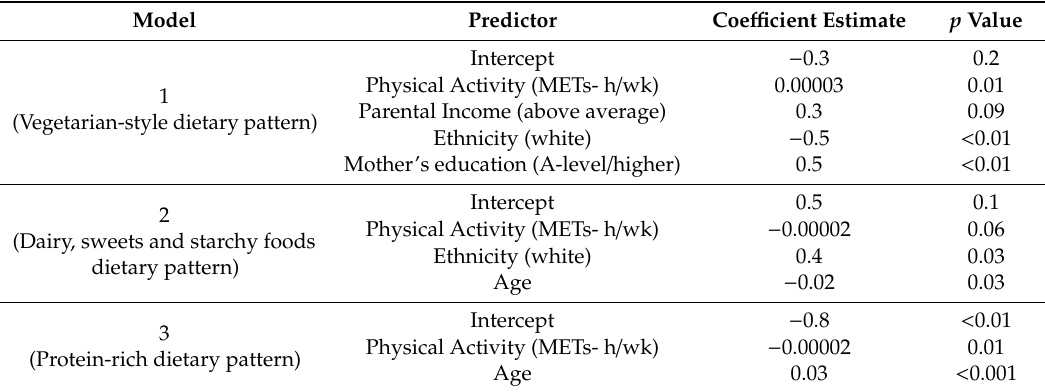
Table 4. Regression models showing the association between a posteriori-derived diet patterns and adiposity measures, physical activity and socioeconomic